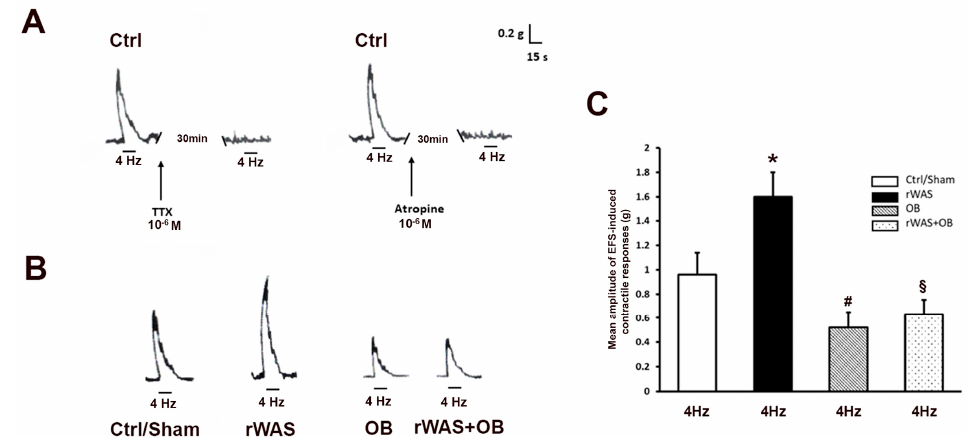
Figure 2. EFS in preparations from the different animal groups and effects of TTX and atropine. ( A ): Typical tracings showing the contractile response to EFS in preparations from Ctrl rats. The response elicited by EFS (4 Hz) is abolished following the addition to the bath medium of either TTX (left-hand panel) or atropine (right-hand panel). ( B ): Typical tracings showing the contractile response to EFS in preparations from: Ctrl, rWAS, OB, and rWAS+OB rats. The amplitude of the neurally induced contractile response to EFS is higher in preparations from rWAS in respect with that recorded from the Ctrl ones. In preparations from both OB and rWAS+OB rats, the amplitude of the contractile response to EFS appears greatly reduced in comparison with that of the rWAS or even Ctrl ones. ( C ): Bar chart showing the mean amplitude of the EFS-induced contractile responses in preparations from the different groups. No statistical differences were observed in the amplitude of the contractile responses to EFS between preparations from Ctrl and Sham rats, so all these data were put together and analyzed (Ctrl/Sham). The mean amplitude of the contractile responses to EFS in preparations from rWAS animals is increased in comparison with the Ctrl/Sham rats. At variance, that of both OB and rWAS+OB rats is reduced, without statistical differences between these two groups, in comparison with Ctrl/Sham and rWAS ones. All values are means ± S.E.M. of